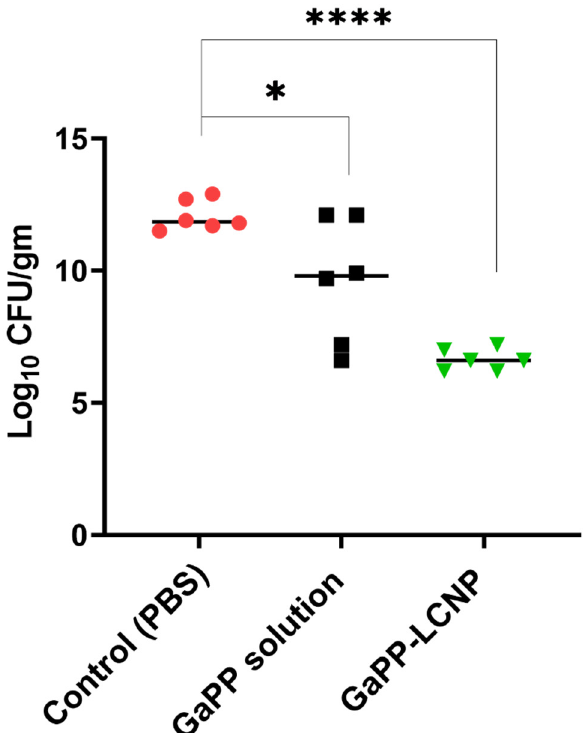
Figure 8. Viability of Xen29 biofilms incubated with PBS, GaPP or GaPP-LCNP 50 µM for 30 min in the dark followed by photoactivation for 10 min; ( n = 6, three technical replicates and 2 biological replicates); * significant reduction p = 0.015; **** p < 0.0001(one-way ANOVA test followed by multiple comparison Dunnett’s test).